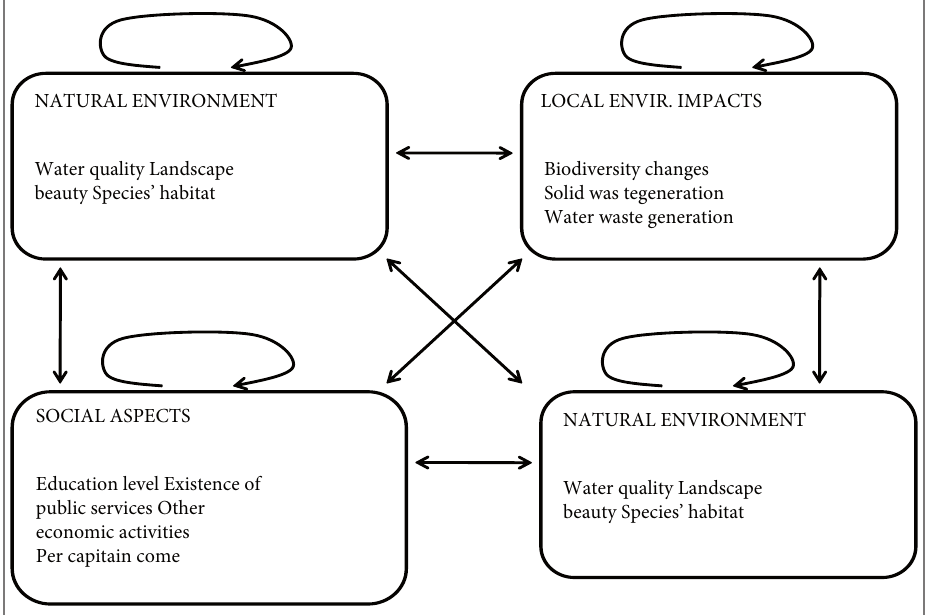
Fig. 3. Network model for the case